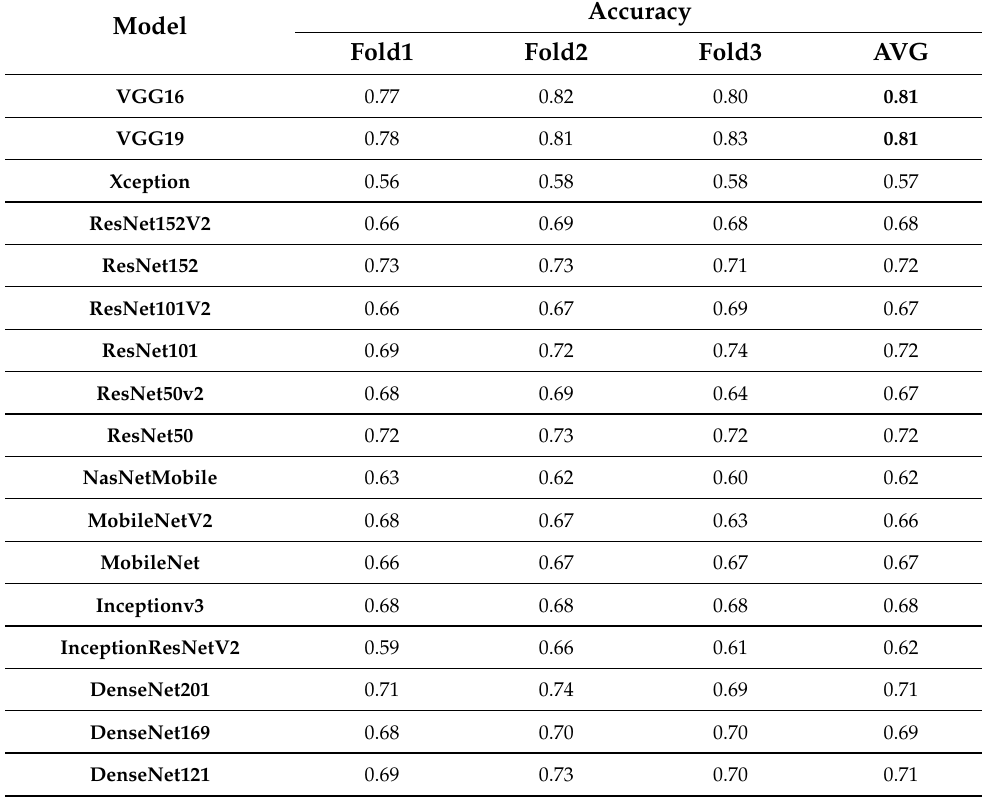
Table 4. Validation accuracy of CNN models using 3 class 3 folds without segment